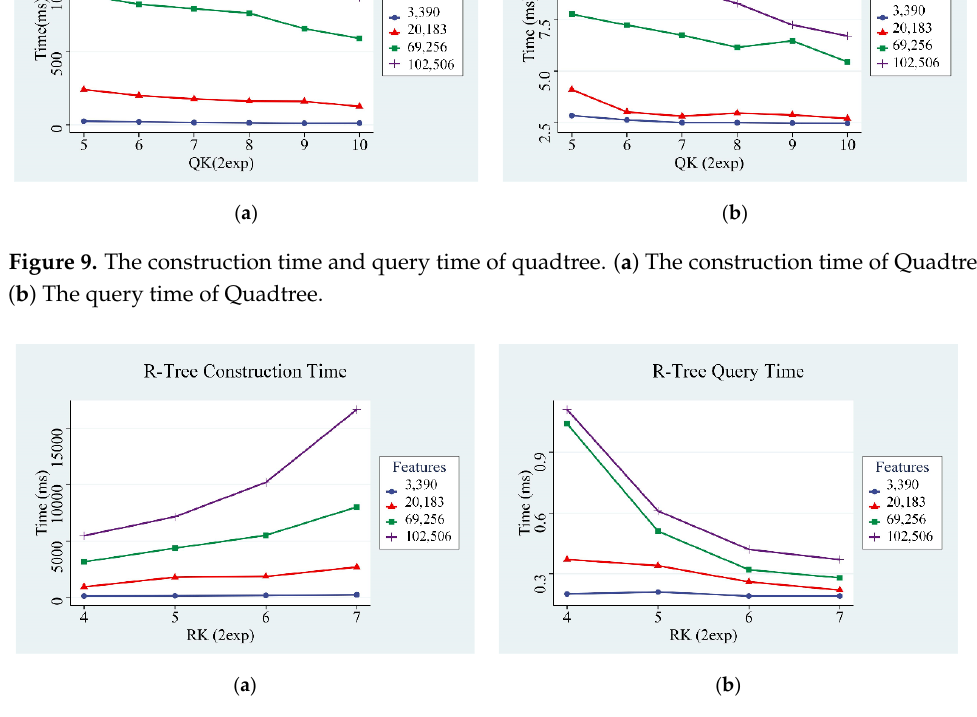
Figure 10. The construction time and query time of R-tree. ( a ) The construction time of R-tree; ( b ) The query time of R-tree.